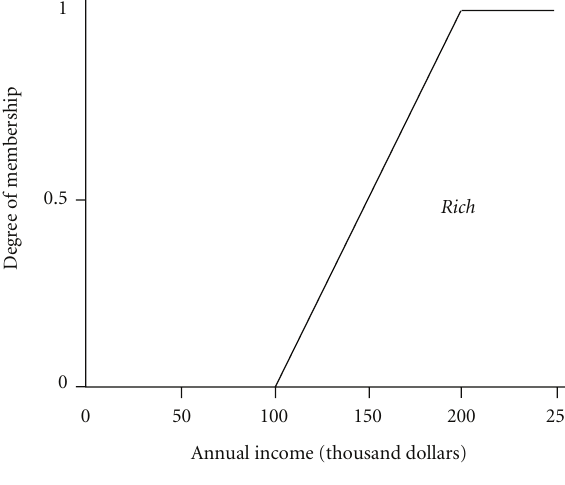
Figure 6: Fuzzy set for rich